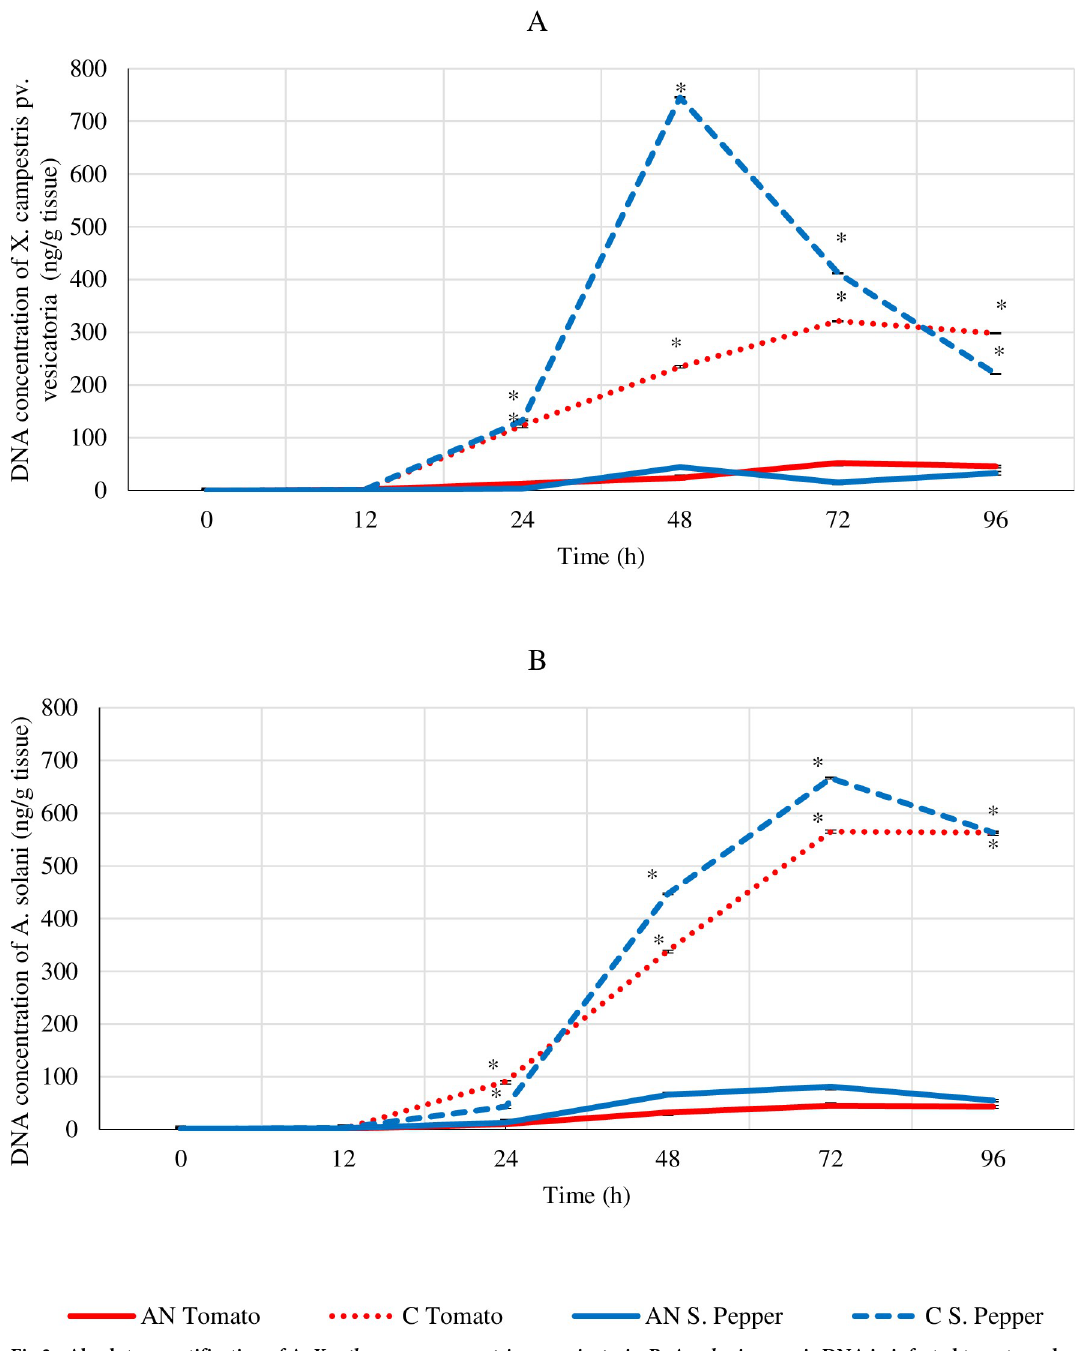
Fig 3. Absolute quantification of A: Xanthomonas campestris pv. vesicatoria ; B: A . solani genomic DNA in infected tomato and sweet pepper leaf tissue over time treated with A . nodosum extract. The data represents the averages ± SD of 2 independent trials with 6 replicates. The data was analysed by repeated measures ANOVA to study the effects of time and treatment. The data was also analysed by Student’s t-test to examine the significance of seaweed extract versus control at each time point independently. � represents significant differences where p-value was less than